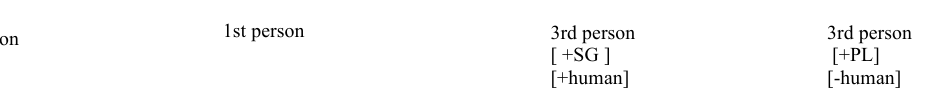
Figure 1 . A representation of Myhill’s (1992: 224) proposed Topicality Hierarchy and his earlier (1989: 242) Animacy